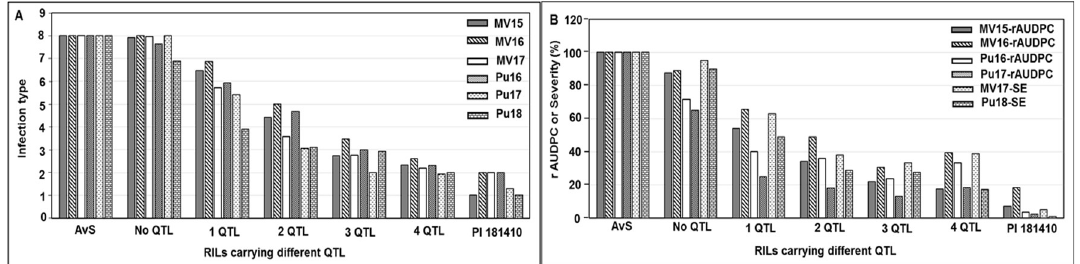
Figure 6. Comparison of mean infection type ( A ) and rAUDPC/severity (SE) ( B ) values of recombinant inbred lines (RILs) derived from cross AvS × PI 181410 containing different HTAP resistance QTL combination.